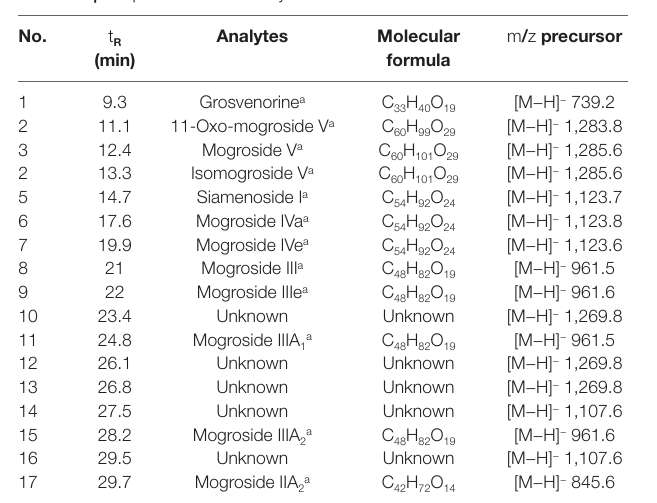
TABLE 1 | MS parameters for analysis of LHG extract.